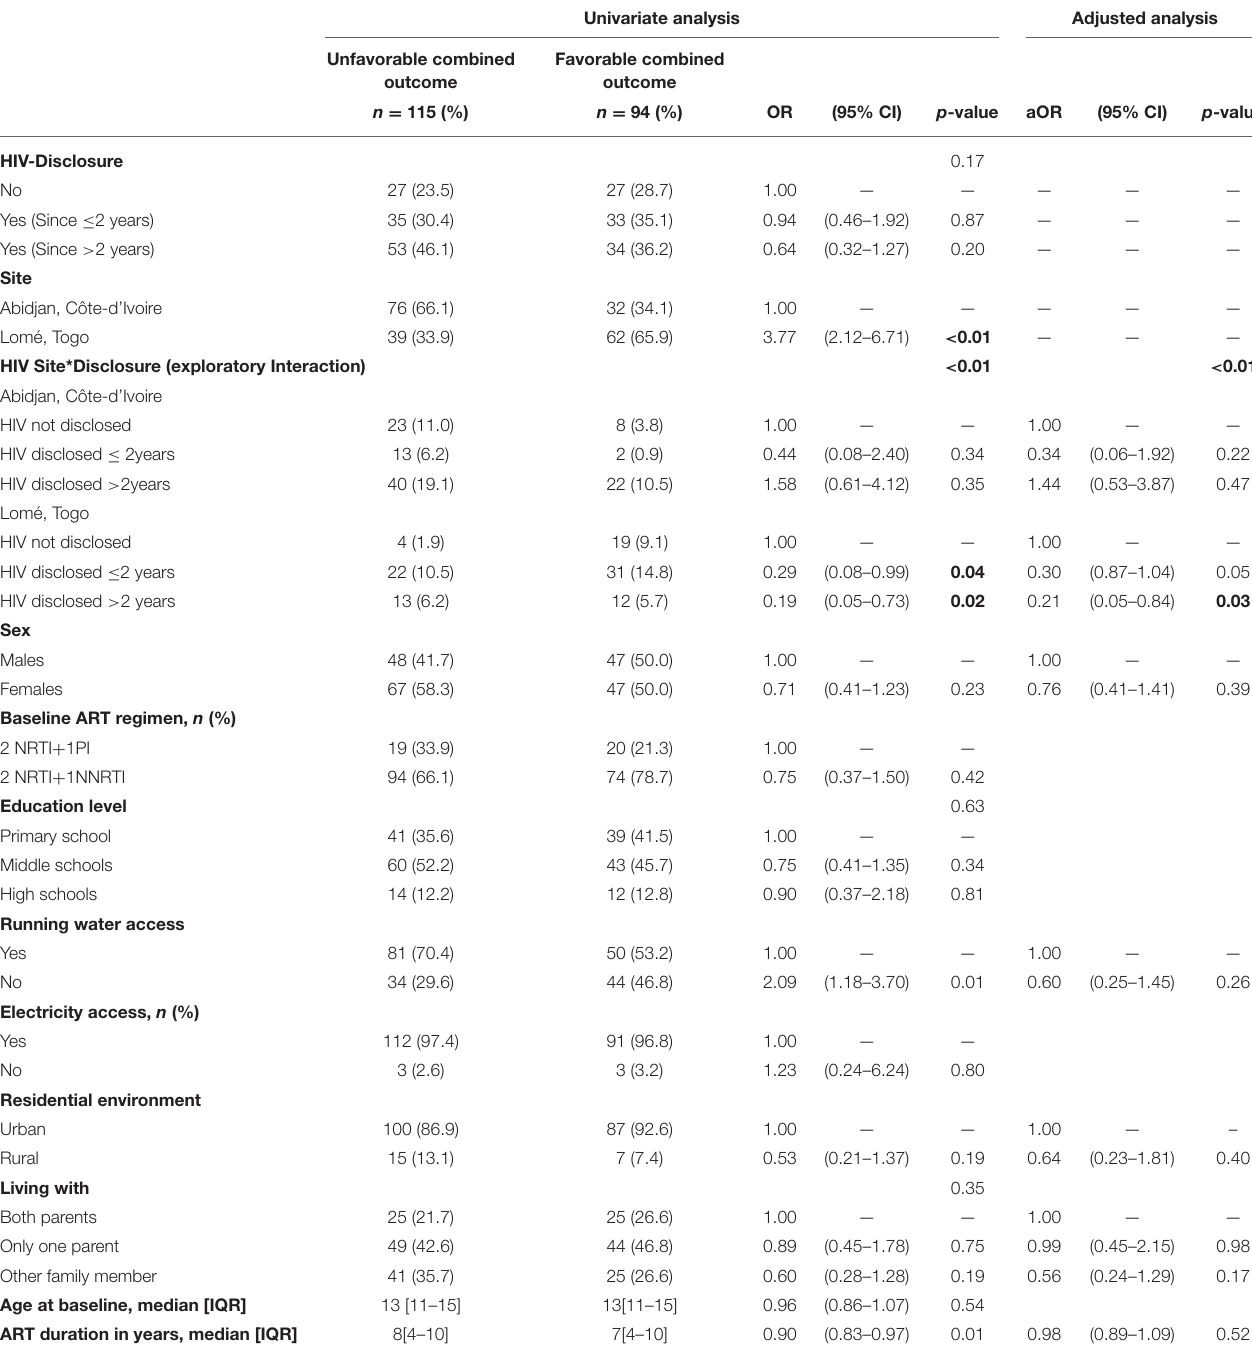
TABLE 7 | Correlates of a favorable combined 24-month health outcome (definition: Table 5 ) of the 209 APHIV included, in the COHADO, IeDEA-pWADA, 2015–2017. Univariate analysis Adjusted